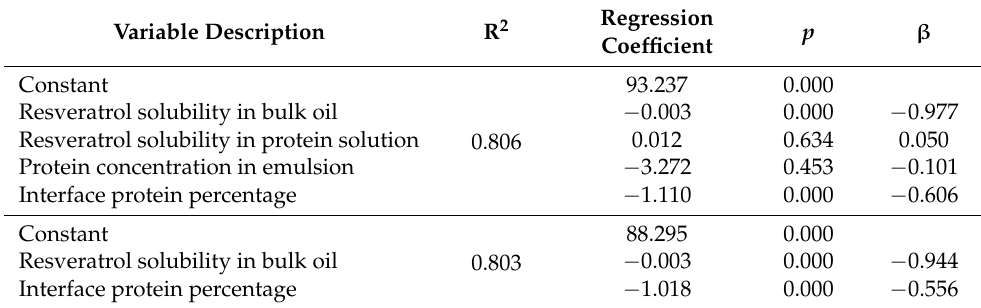
Table 2. Multiple linear regression analysis of the percentages of resveratrol in the aqueous phase of fish oil, sunflower oil, MCT and peppermint oil emulsions.